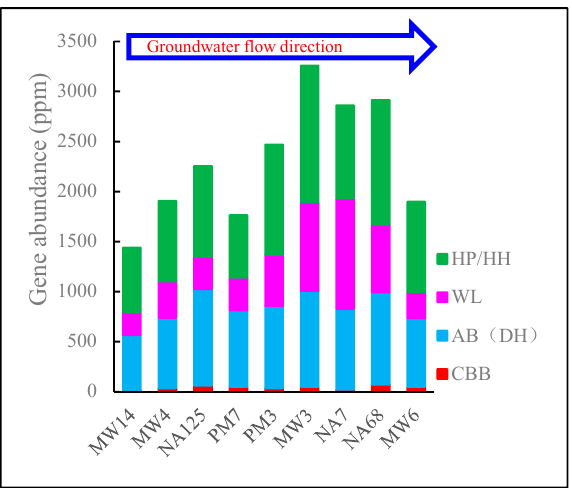
Figure 2. Distribution of carbon fixation genes. HP, 3-hydroxypropionate; HH, hydroxypropionate-hydroxybutyrate; WL, Wood-Ljungdahl; AB, Arnon-Buchanan; DH, dicarboxylate-hydroxybutyrate; CBB, Calvin-Benson-Bassham.